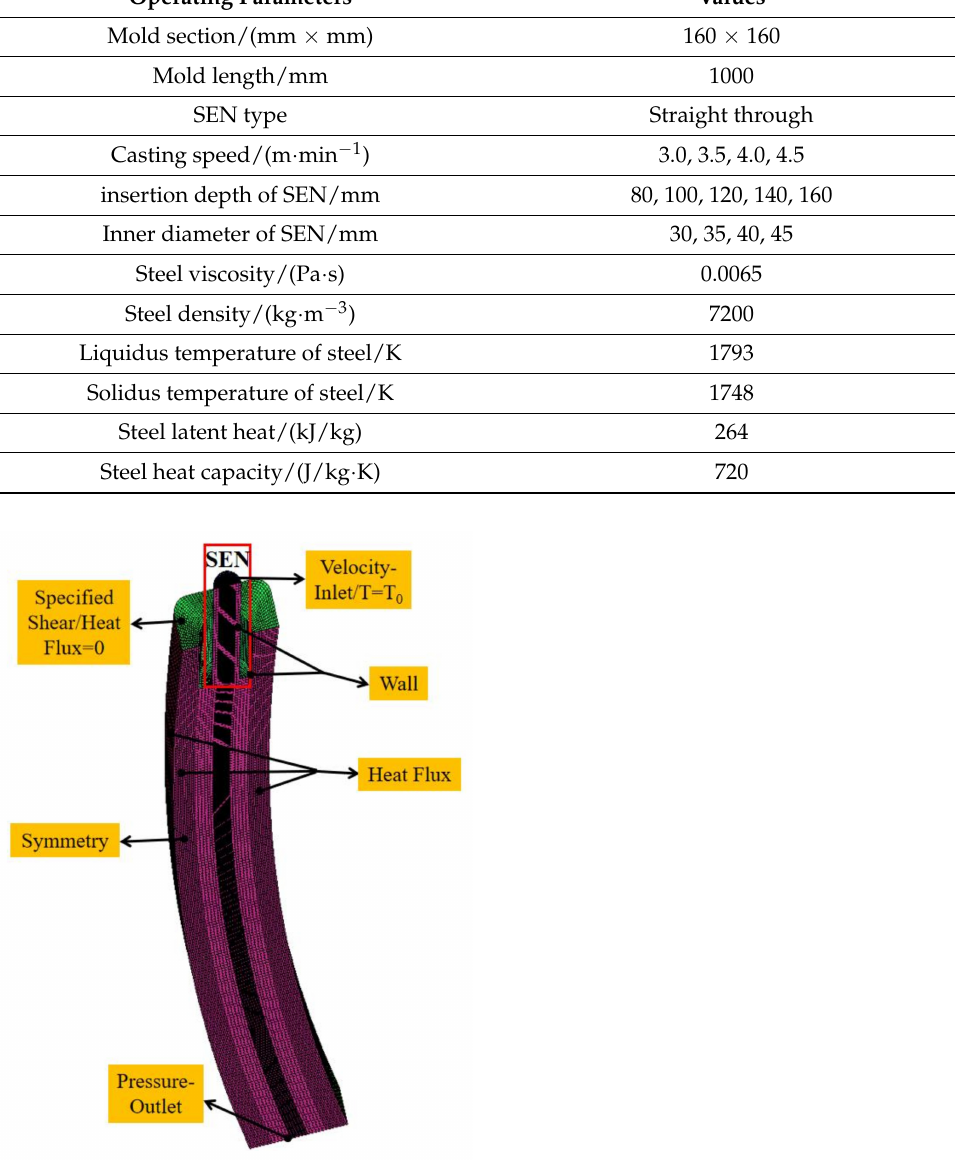
Figure 1. Schematic diagram of model boundary condition loading and mesh